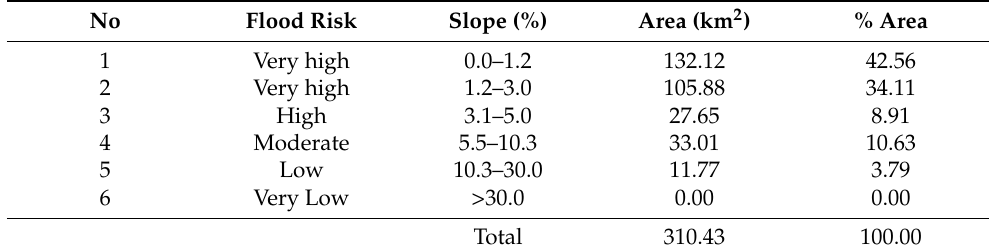
Table 7. Flood risk class based on different slopes of Krueng Teunom watershed and its coverage